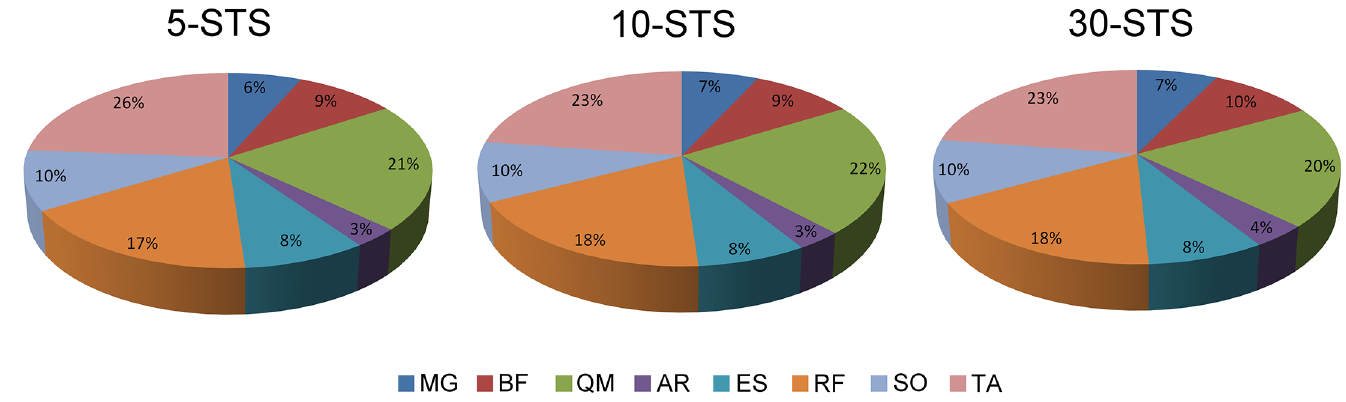
Fig 2. Distribution of muscle involvement in 5-STS, 10-STS and 30-STS.